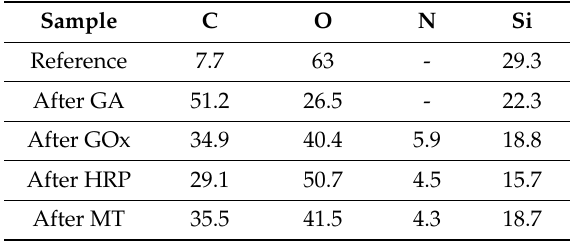
Table 1. Relative abundance (% of atoms) of the measured elements (C, O, N, Si) after each step of the immobilization protocol.